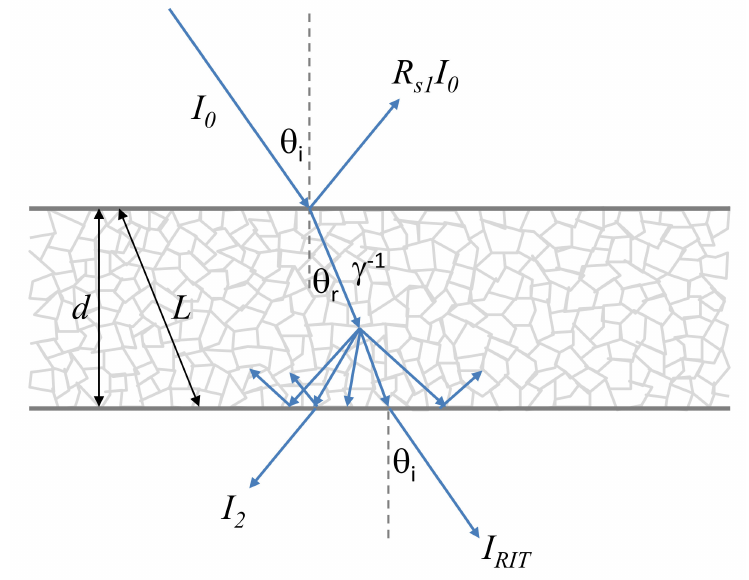
Figure A2. Schematic illustration of the di ff erent scattering contributions to the total path